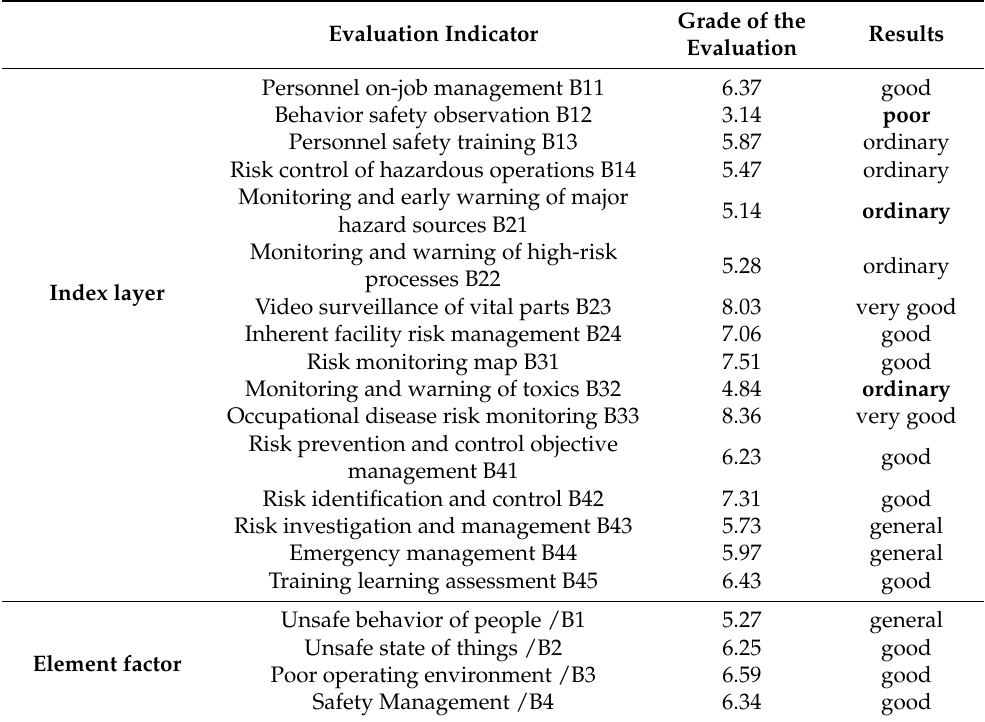
Table 8. Evaluation results of evaluation indexes at each